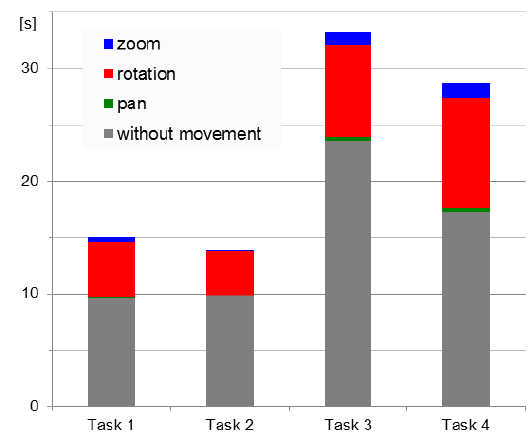
Fig. 7. Average duration of use of individual types of